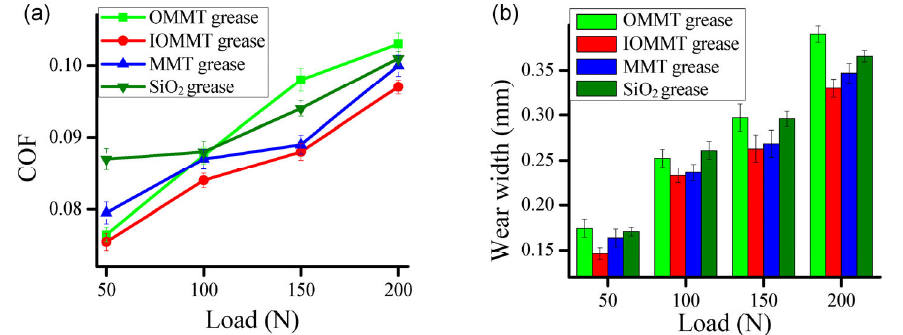
Fig. 6 The average COFs (a) and wear widths change (b) under the lubrication with insulating greases at different loads, 5 Hz, and RT.